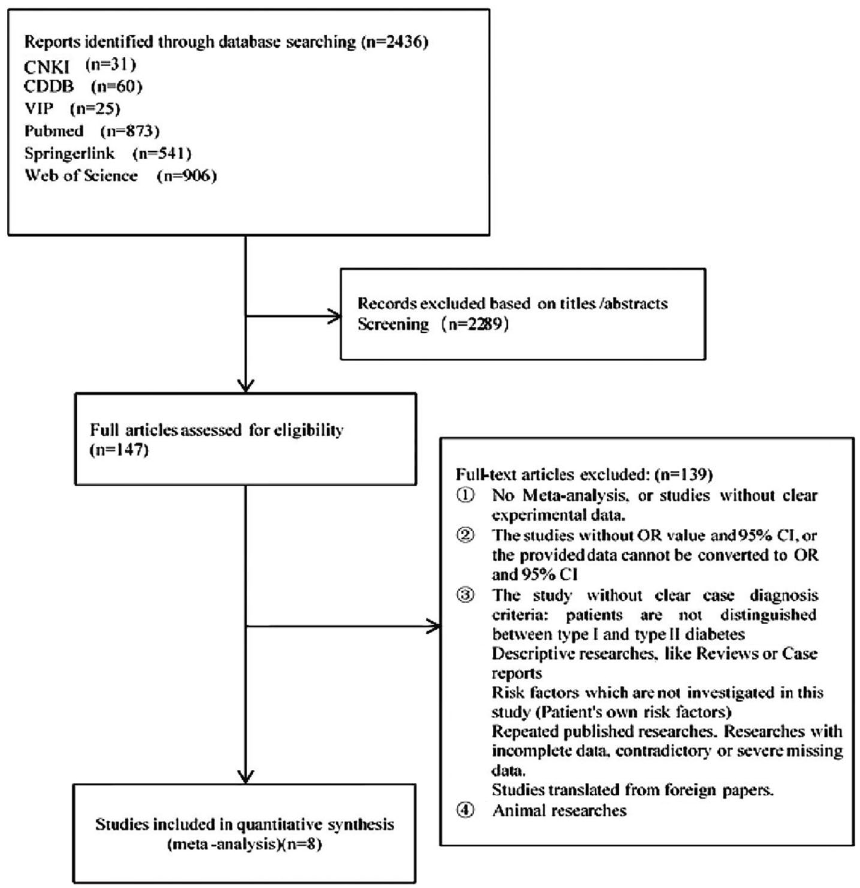
Figure 2. Flow chart of literature search and study selection.